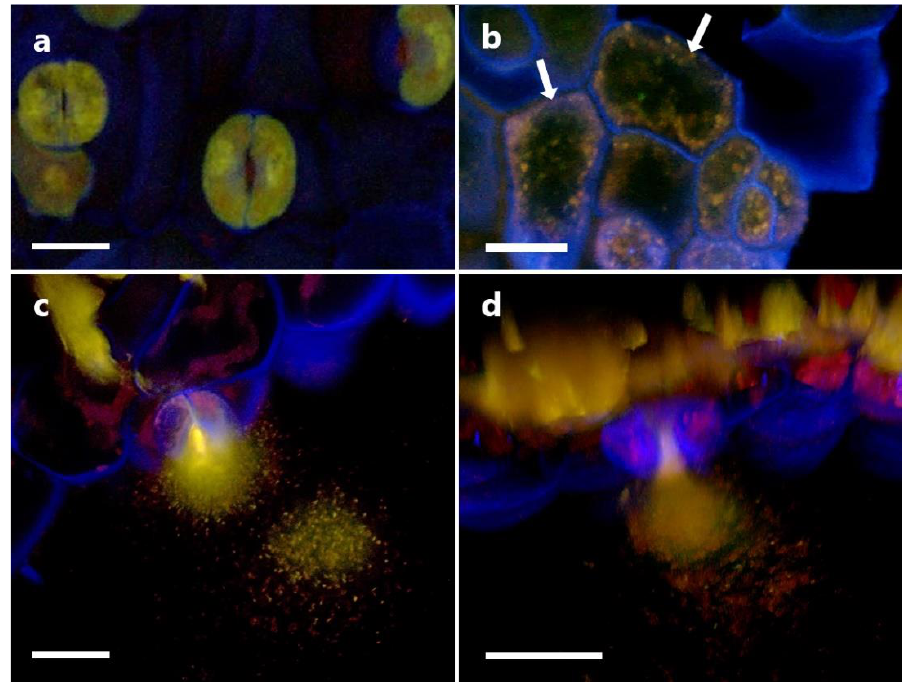
Figure 16. P3AW: mCherry being ejected through an open stoma in the cotyledons of inoculated clover plants. ( a ) A 2D image of the stomata and guard cells of an uninoculated clover plant. ( b ) A 2D image of the guard cells of an P3AW: mCherry -inoculated clover plant. ( c ) A 2D and ( d ) 3D image of a plume of P3AW: mCherry cells escaping from the stoma opening. Scale bar = 20 µ